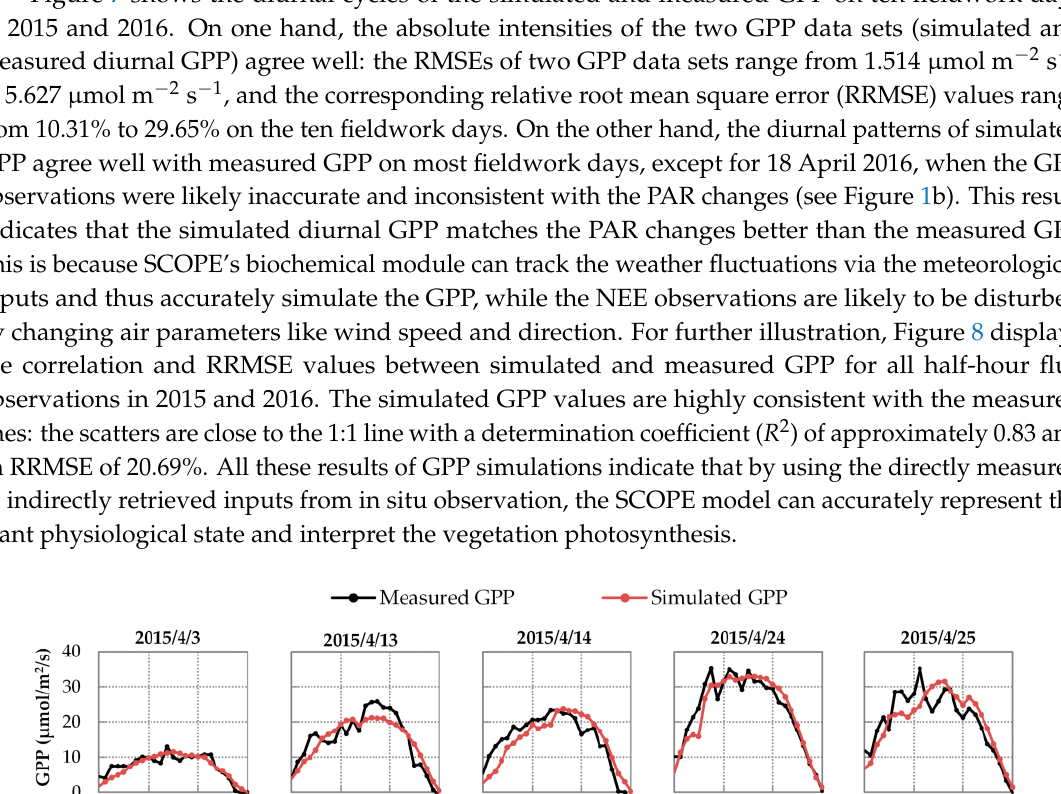
Figure 6. Root mean squared error (RMSE) values between the simulated and measured reflectance spectra for 106 spectral measurements in 2015 and 2016.